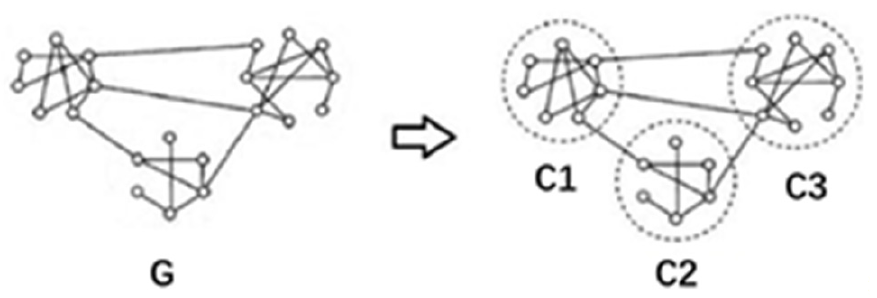
Figure 3. General single-layer network diagram.